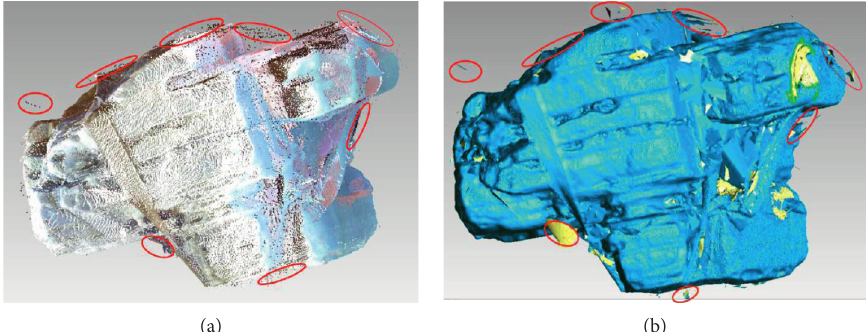
Figure 3: Error points and geometric distortion. (a) Error points cloud. (b) Geometric distortion after the